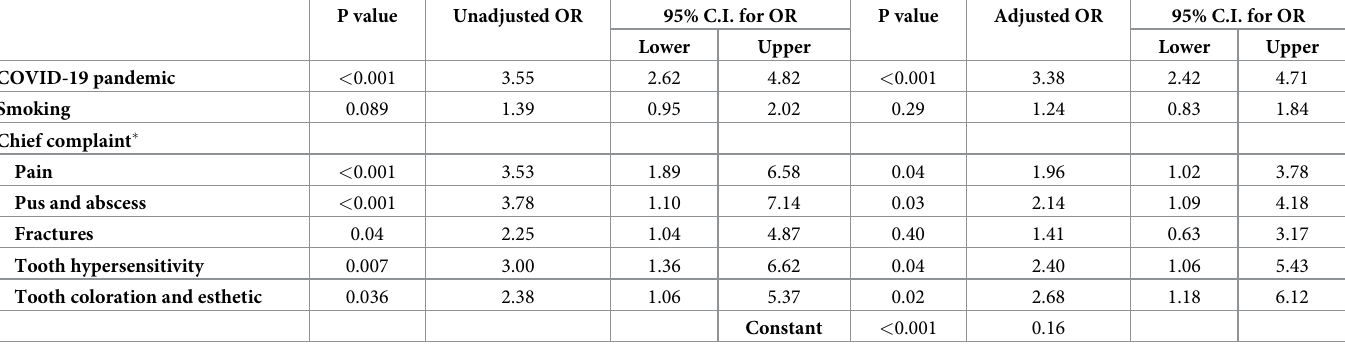
Table 2. Association of smoking, COVID-19 pandemic, and chief complaint with self-medication with antibiotics among a group of dental patients (n = 756) in Iran using simple (unadjusted) and multiple (adjusted) logistic regression models. P value Unadjusted OR 95% C.I. for OR P value Adjusted OR 95% C.I. for OR Lower Upper Lower